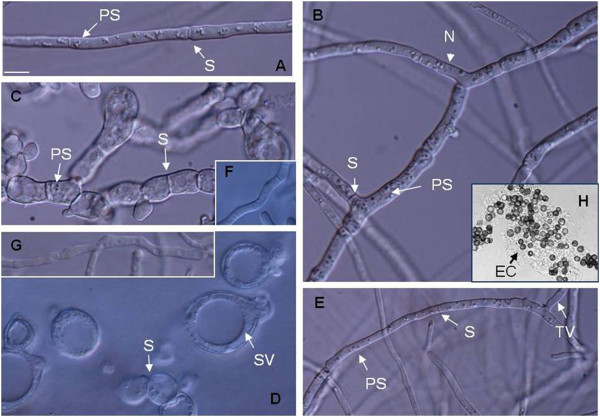
Microscopic morphology of A. niger MYA 135 in submerged fermentation. Differential interference contrast images of cells developed in a basic medium at 25 (A), 30 (B) and 37°C (C) as well as those obtained in the presence of either 0.5 g |-1 CaCl2 (D) or 1 g |-1 FeCl3 (E). Restored cells observed at 37°C (F) or in the presence of 0.5 g |-1 CaCl2 (G) with the supplementation of 1.5 M NaCl. These images were taken after 72 h of cultivation. Extracellular compound (EC) produced during the early stages of pellets formation (H). All Panels are at the same magnification as A. Bar represents 10 μm. SV (Spherical Vacuole), TV (Tubular Vacuole), S (Septum), N (Nucleus), PS (Punctuate Structures).